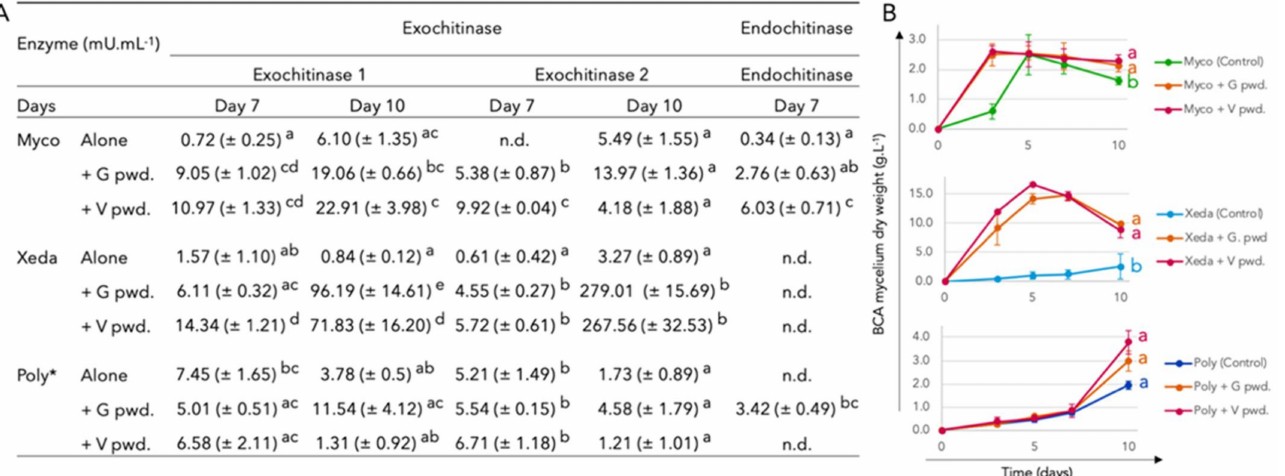
Figure 6. ( A ) BCAs chitinases activities in presence of pathogens mycelium fragments. Chitinase activity (mU.mL − 1 ) of BCAs alone or in contact with mycelium powder of pathogen at day 7 or 10 (endochitinase was tested only at day 7). ( B ) Dry weight evolution of BCA during chitinase test (g.L − 1 ). Minimum media was liquid and adapted for each BCAs growth. Cultures were carried out at 25 ◦ C under agitation of 150 RPM during 10 days. Exochitinase 1: chitobiosidase activity, Exochitinase 2: β -N-acetylglucosaminidase activity and Endochitinase: endochitinase activity; G pwd.: F. graminearum mycelium powder. V pwd.: F. verticillioides mycelium powder; n.d.: not detected. * To confirm the apparent constitutive synthesis of exochitinase by Poly, supplementary analysis was performed on solid media, and comparable profile was detected. Myco: Mycostop ® , Xeda: Xedavir ® , Poly: Polyversum ® . ANOVA test, between BCAs (all conditions combined (Alone, + G.pwd., + V pwd.)) for each chitinase (Exochitinase 1, Exochitinase 2, Endochitinase) and day (day 7 or 10) analyzed independently (a, b, c, d), p -value <